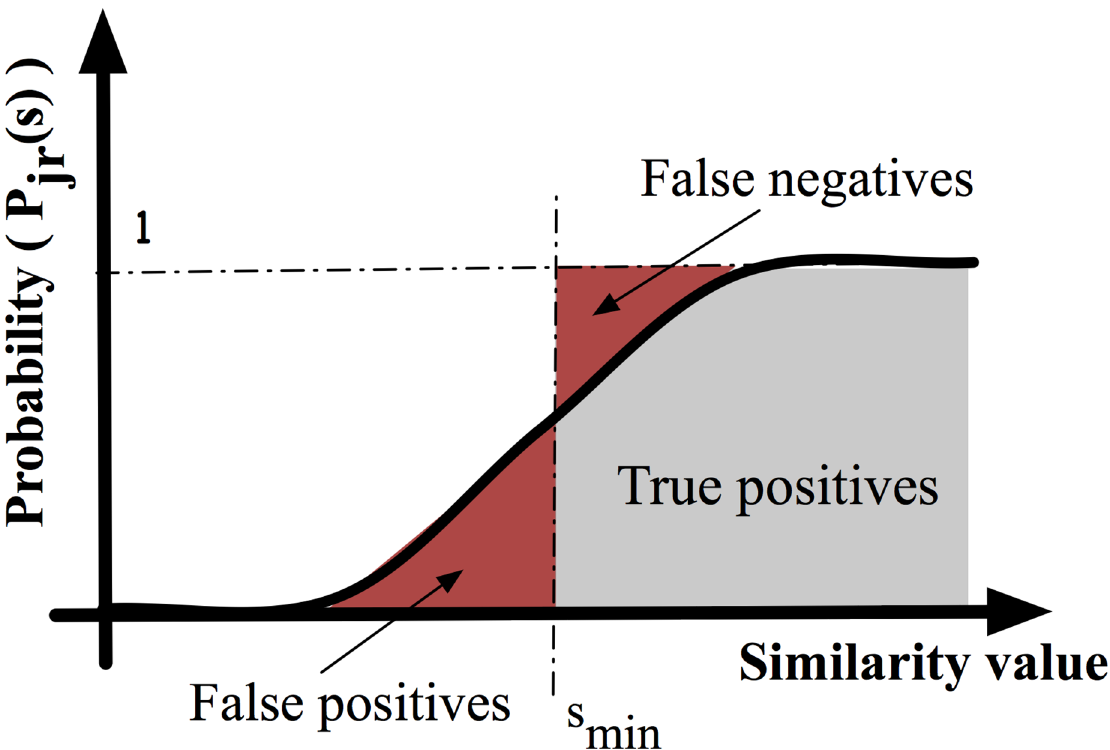
Fig 14. For each computation, a given number of false positives and negatives are provided by the probabilistic system. False positives can be filtered out by software while false negatives are lost.